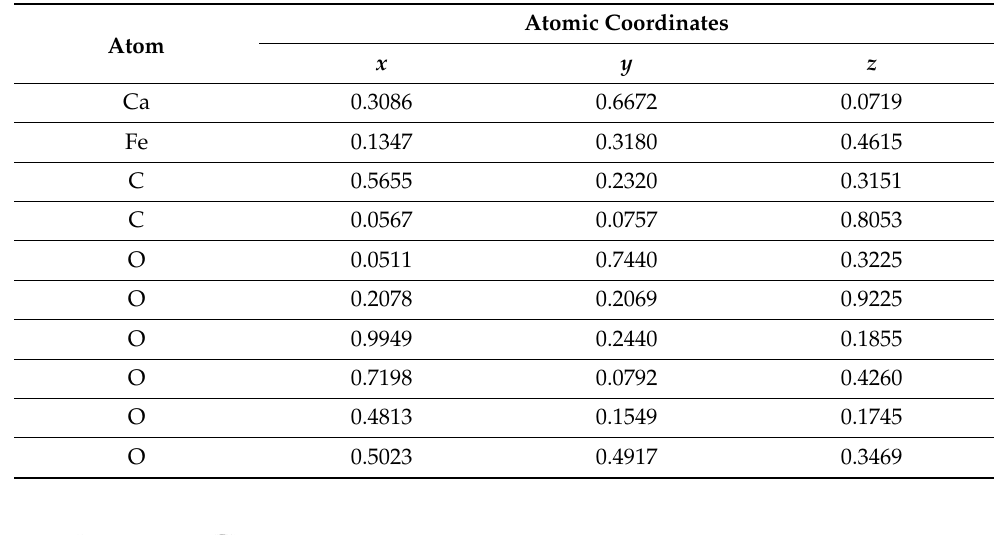
Table 2. Calculated atomic coordinates for the P -1 “HP-ankerite” phase at 35.2 GPa. The lattice parameters at this pressure would be: a = 4.985 Å, b = 4.136 Å, c = 8.250 Å, α = 76.11 ◦ , β = 99.13 ◦ , and γ = 105.82 ◦ .